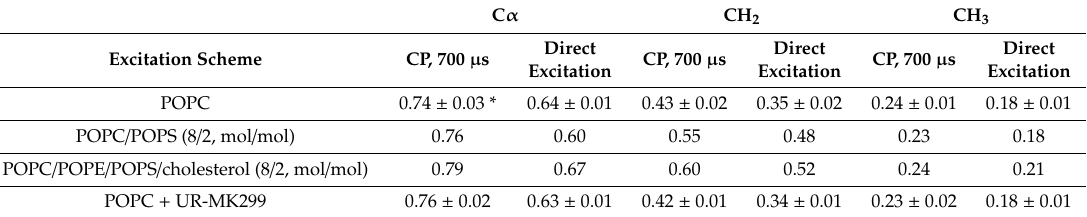
Table 2. Molecular order parameters S CH of Y1R reconstituted into POPC, POPC/POPS (8/2, mol/mol), and POPC/POPE/POPS/cholesterol (4/4/1/1, mol/mol/mol/mol) membranes at a temperature of 37 °C.